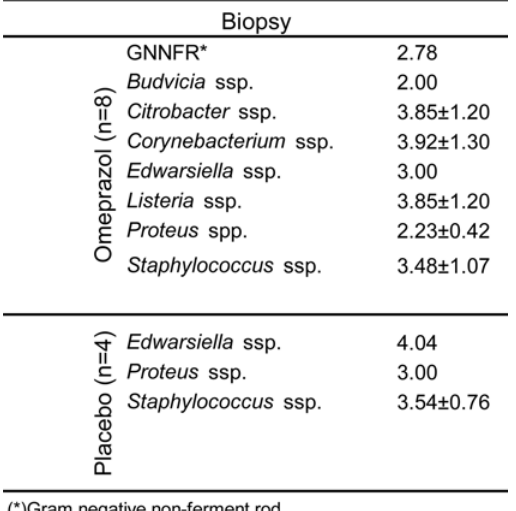
TABLE 5 - Bacteria strain [Ln(UFC/ml)] (mean ± SD or unit value) obtained by biopsy after administration of omeprazol/placebo.